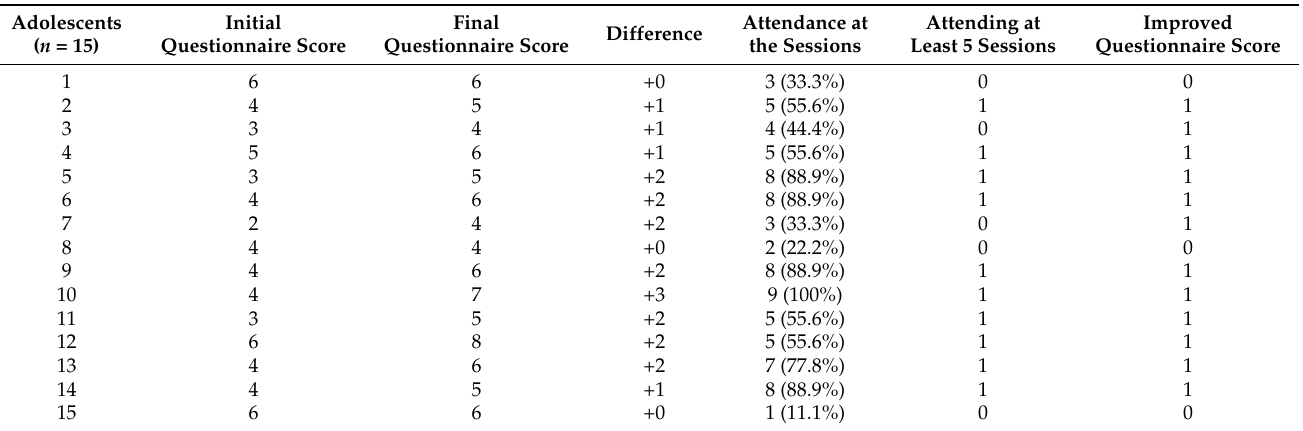
Table 6. Difference in the scores of the nutritional knowledge questionnaires and in attendance at the food education